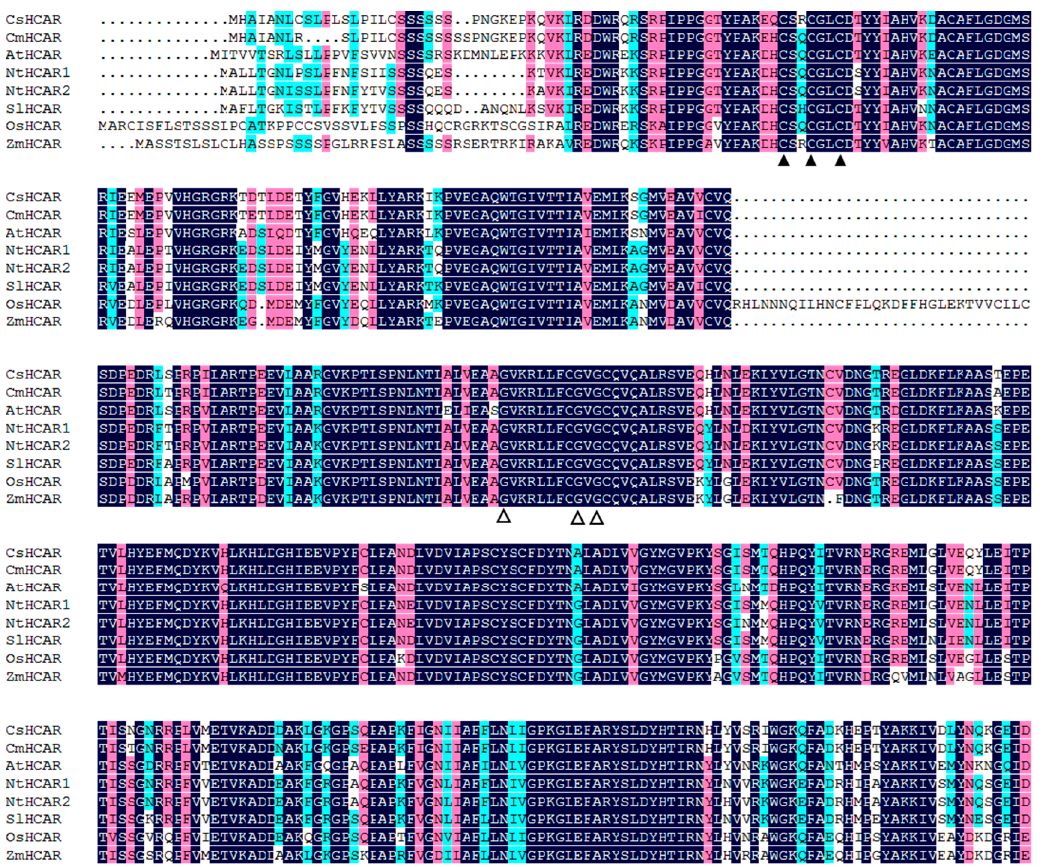
Figure 1. Alignment of the amino acid sequences of HCAR proteins among seven species. Conserved residues are shaded with black. Filled triangles represent the cysteine residues that are predicted to coordinate the iron-sulfur cluster. Open triangles represent the conserved sequence motif in FAD-containing proteins (K×××××G×G). Cs, Cucumis sativus ; Cm, Cucumis melo ; At, Arabidopsis thaliana ; Nt, Nicotiana tabacum ; Sl, Solanum lycopersicum ; Os, Oryza sativa ; Zm, Zea mays .